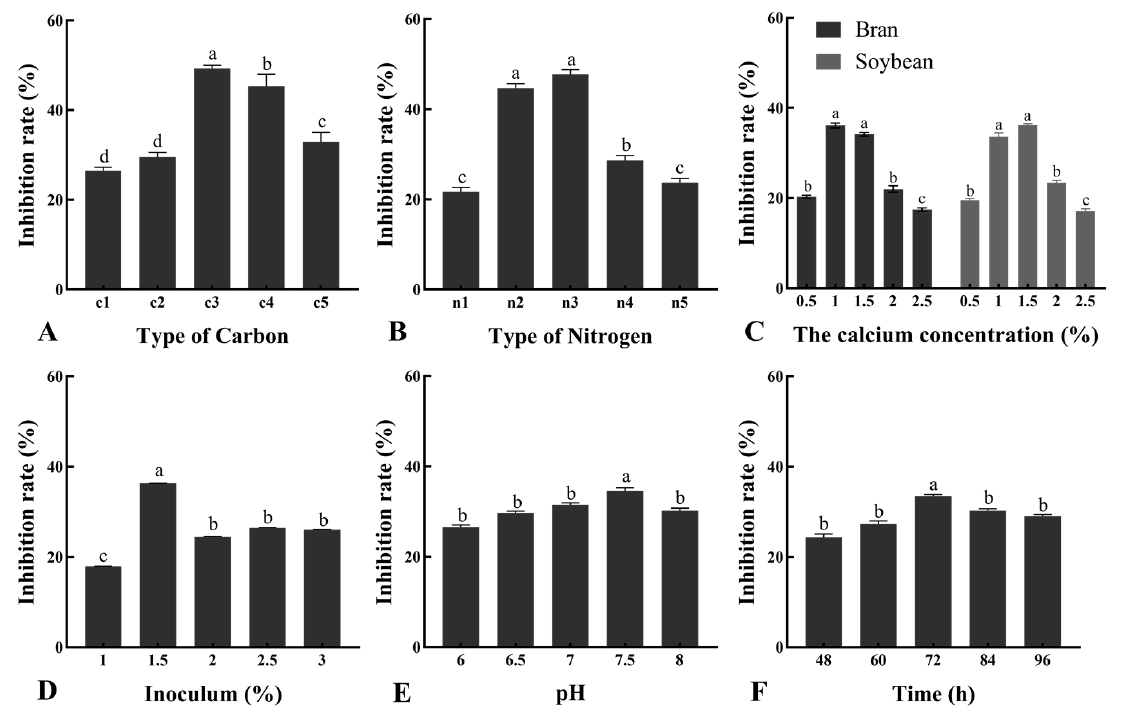
Figure 4. Effect of cultivation medium components and cultural conditions on the activities of strain B1302 against R. cerealis . ( A ), Carbon (c1, corn; c2, glycerin; c3, wheat bran; c4, sucrose; c5, glucose); ( B ), Nitrogen (n1, peptone; n2, yeast extract; n3, soybean meal; n4, soybean powder; n5, NaNO 3 ); ( C ), Calcium concentration; ( D ), Inoculation amount of bacteria; ( E ), pH; ( F ), cultivation time. Data in the figure are the mean ± SE. Different lower-case letters on the bars indicate the significant difference at the p < 0.05 level using Duncan’s multiple range